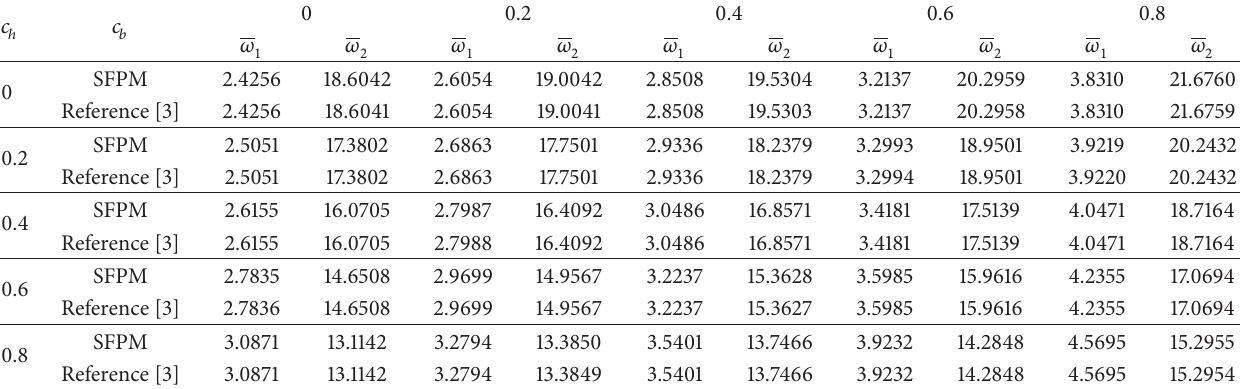
Table 6: Nondimensional transverse natural frequencies 𝜔 𝑖 for axially FG tapered beam; boundary condition: C-F.